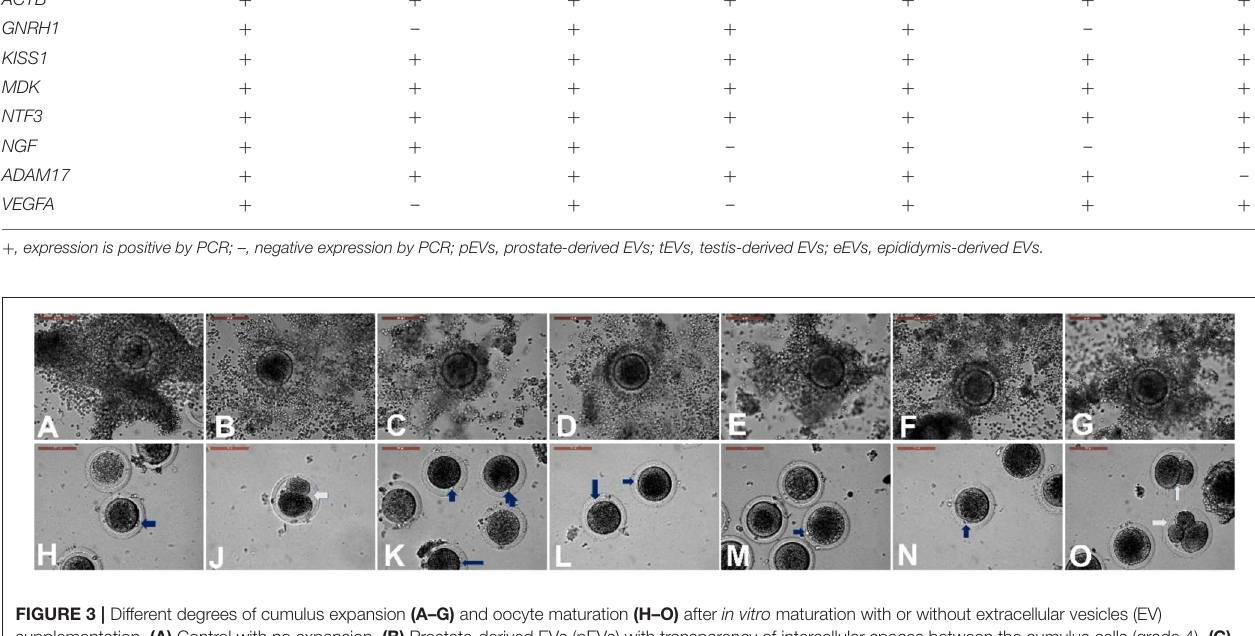
FIGURE 3 | Different degrees of cumulus expansion (A–G) and oocyte maturation (H–O) after in vitro maturation with or without extracellular vesicles (EV) supplementation. (A) Control with no expansion. (B) Prostate-derived EVs (pEVs) with transparency of intercellular spaces between the cumulus cells (grade 4). (C) Testis-derived EVs (tEVs). (D) Epididymis-derived EVs (eEVs). (E–G) Supplementation with 10ng/ml NGF (E) , 20ng/ml NGF (F) , and 30ng/ml NGF (G) . Panels (H–O) show the state of oocyte maturation of the corresponding groups of (A–G) . Blue arrows indicate the extrusion of the first polar body. White arrows indicate spontaneously cleaved oocytes. Scale bar, 100 µ